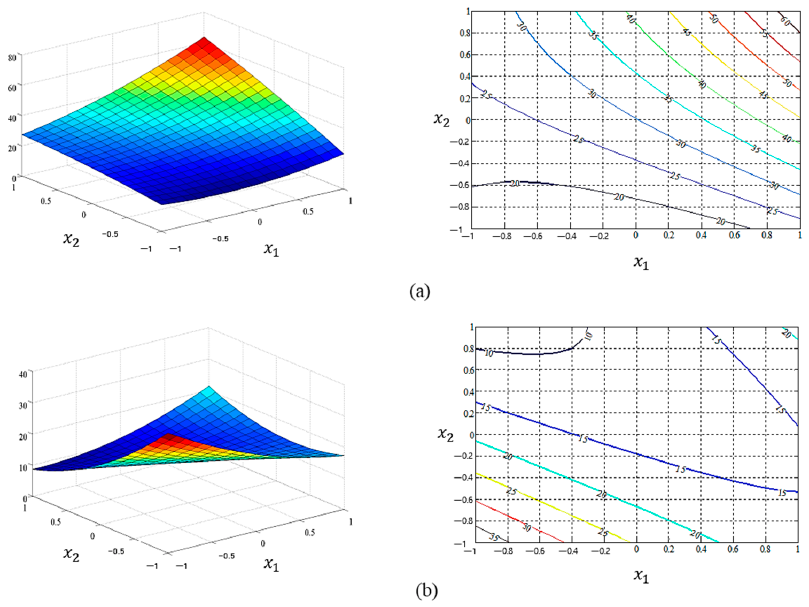
Figure 5. Graphical representation of the estimated standard deviation response functions between 𝑥 (cid:2869) and 𝑥 (cid:2870) : ( a ) the response surface plot and response function of LSM ( 𝑅 (cid:2870) = 45.41% and RMSE = 34.78); ( b ) the response surface plot and response function of NN ( 𝑅 (cid:2870) = 44.18% and RMSE = 35.17).